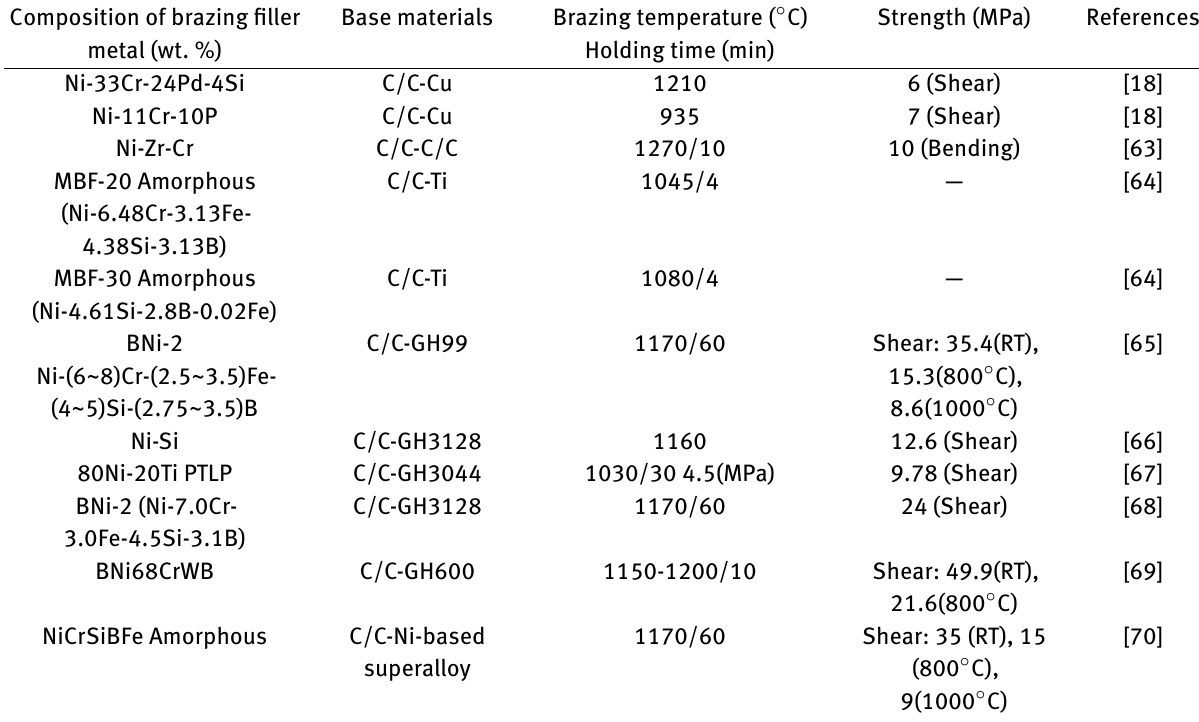
Table 5: Ni-based brazing filler metals used in joining of C/C composites Composition of brazing